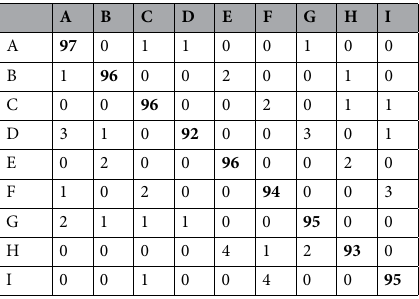
Table 8. Identification confusion matrix of the Cambridge hand gesture dataset. Significant values are in bold.